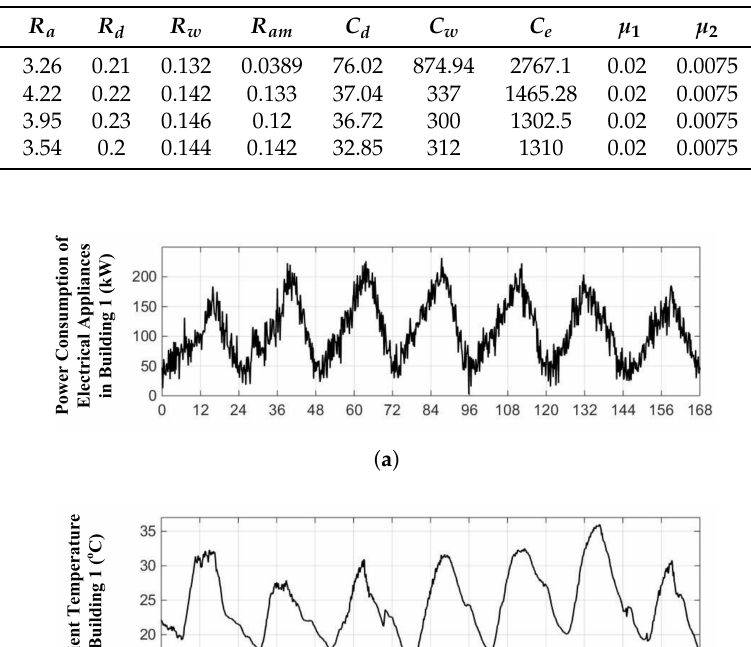
Table 2. Values of thermal parameters for four types of buildings.